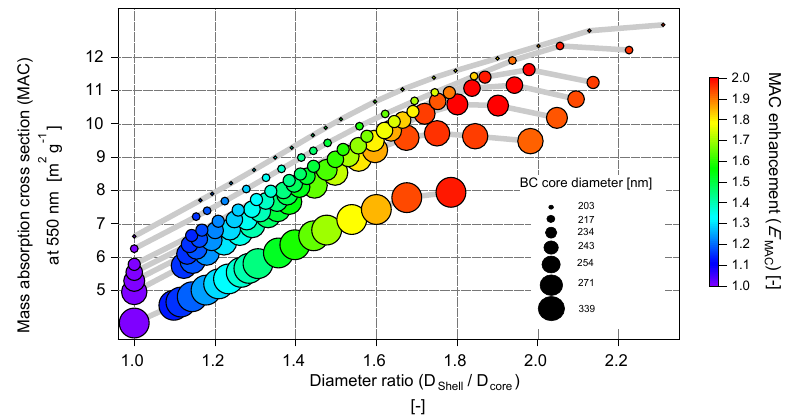
Figure 6. Mass absorption cross section (MAC Mod ) of BC-containing particles calculated according to Mie theory as a function of its mixing degree and BC core diameter assuming a core–shell mixing geometry. MAC enhancement ( E MAC ) is defined as the ratio of the MAC of a coated BC core divided by the MAC of the same BC core without